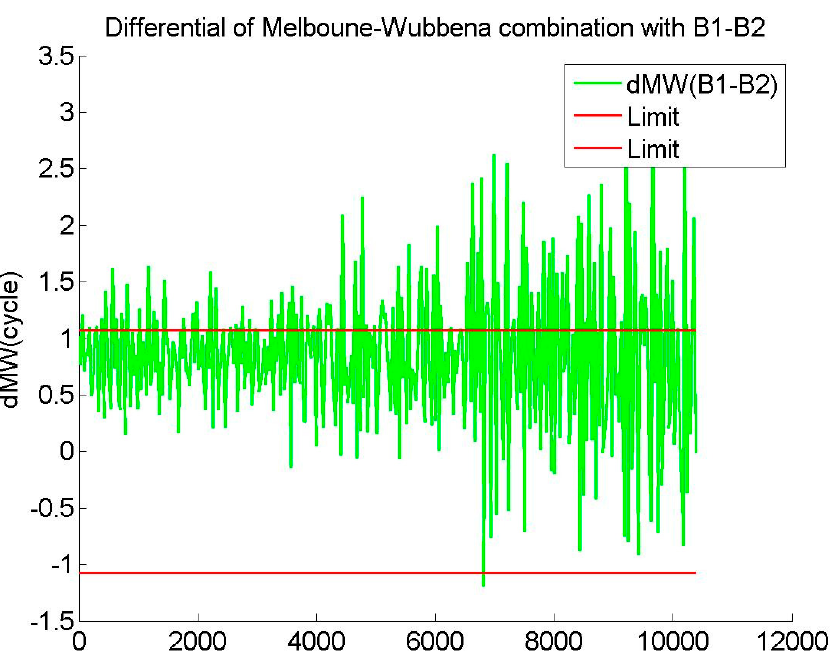
Figure 13. Floating values of the BDCSR methodology’s cycle ‐ slip combination in the case of ap ‐ pending gross errors of 0.7 m on all real epoch ‐ difference pseudoranges from MEO Satellite 11 under a weak condition of low elevations during the geomagnetic storm, where the phase data without cycle slip was collected at the CUT0 station started from UTC 8 May 2016 00:00:00 with an interval of 30 s.